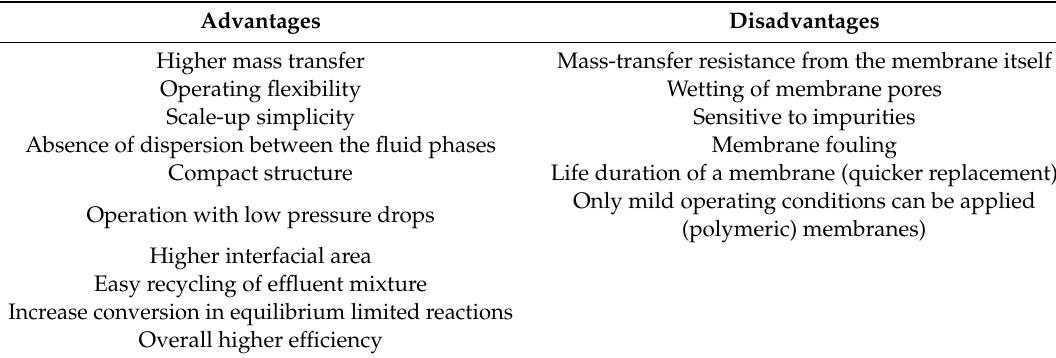
Table 3. Main advantages and disadvantages of membrane contactors